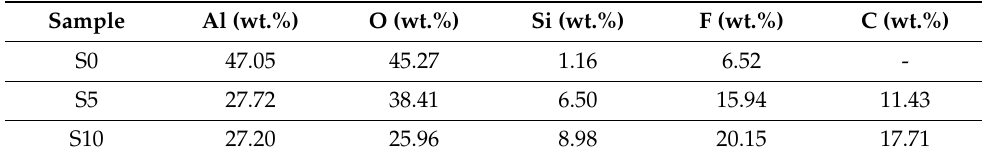
Table 1. Results of EDS conducted on the surface of S0, S5, and S10 samples. Sample